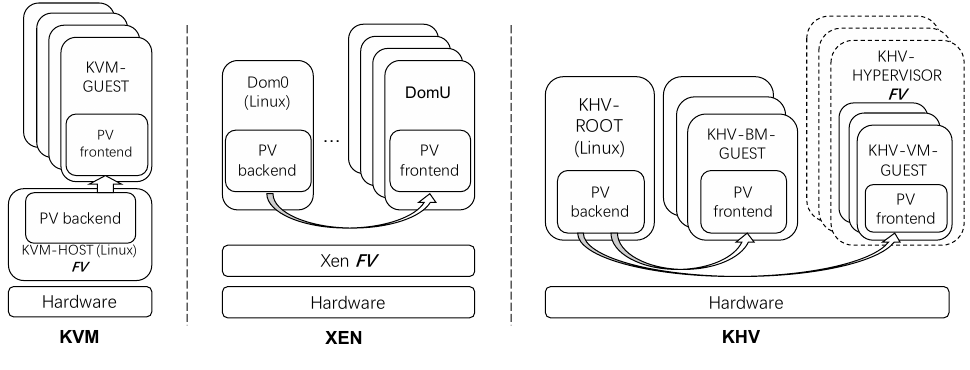
Figure 1. KVM vs. XEN vs. KHV. Table 1. KHV instances noun